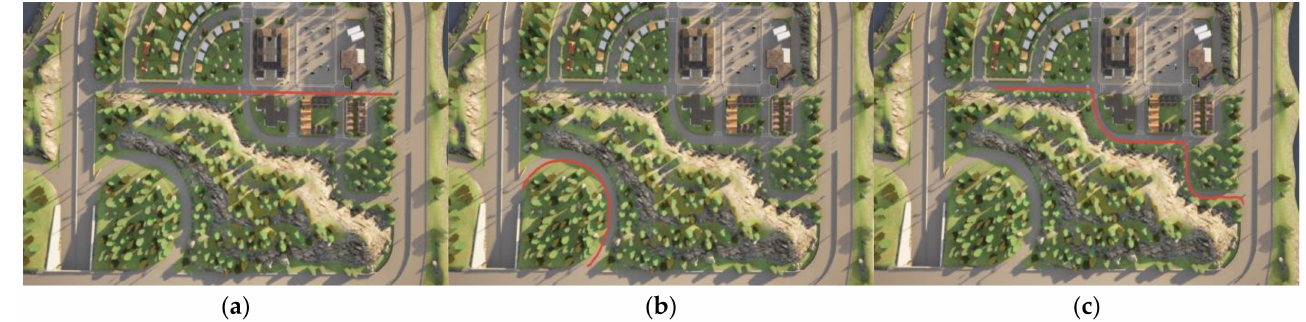
Figure 4. Experimental environment diagram: ( a ) linear tracking environment, ( b ) ramp tracking environment, and ( c ) complex tracking environment.